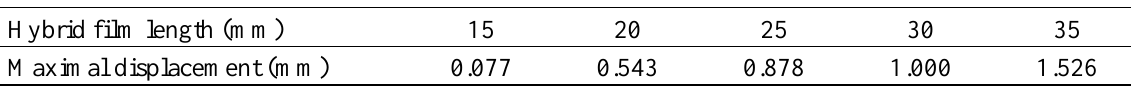
Figure 10. Maximal displacement curves of the samples versus the initial separating distance between these and the electromagnet for the: ( a ) magnetic hybrid film, ( b ) smart composite material. Table 4. Maximal displacements for each evaluated length of the magnetic hybrid samples (external magnetic field: 500